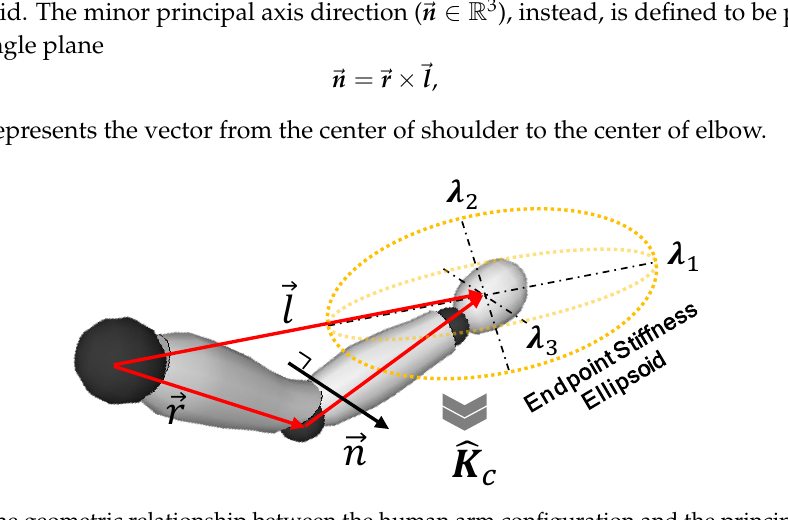
Figure 2. The geometric relationship between the human arm configuration and the principal axes of the endpoint stiffness ellipsoid. (cid:126) n is perpendicular to the plane formed by (cid:126) l and (cid:126) r . (cid:126) l and (cid:126) n are parallel to the major and minor principal axes of the endpoint stiffness ellipsoid,